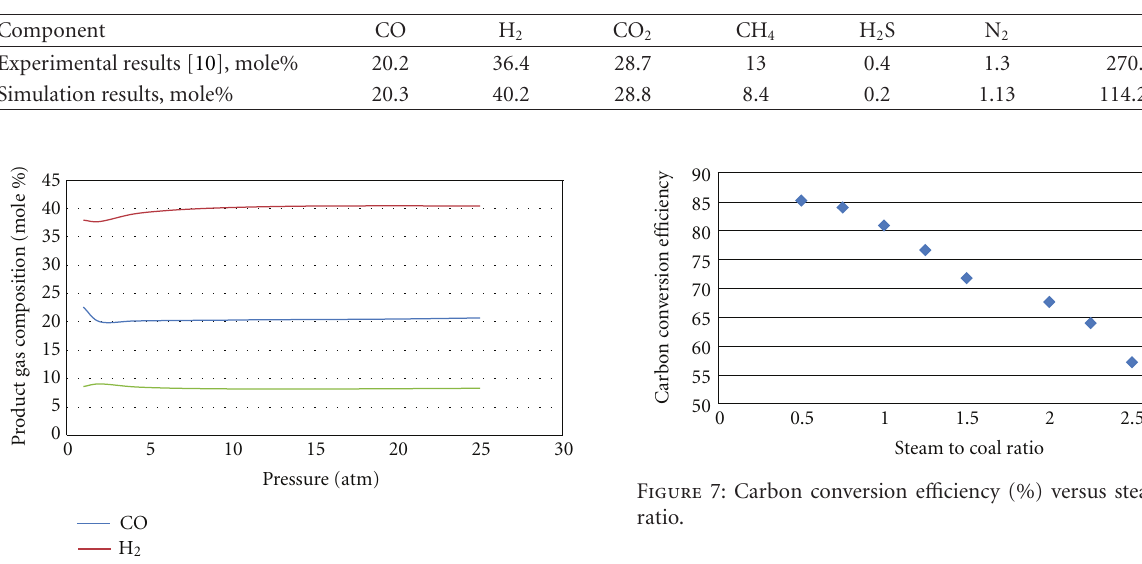
Table 5: Comparing product gas composition of model with experimental data.